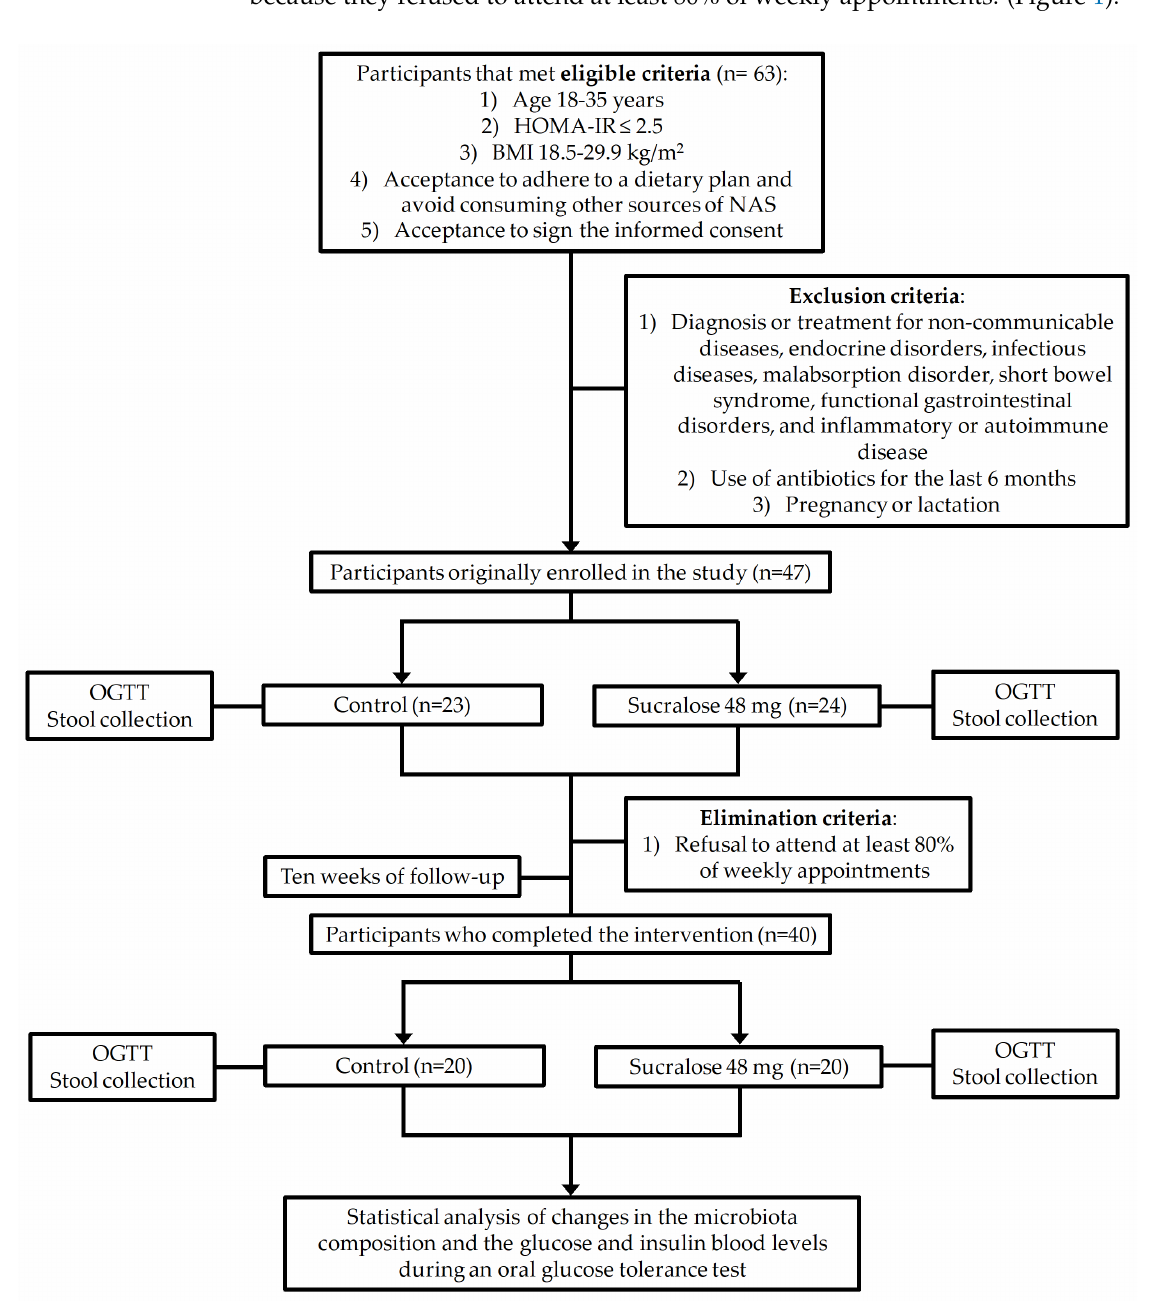
Figure 1. Schematic flow chart showing the selection process of participants enrolled in the study. Homeostasis model assessment of insulin resistance (HOMA-IR); body mass index (BMI); non-caloric artificial sweeteners (NAS); oral glucose tolerance test (OGTT).